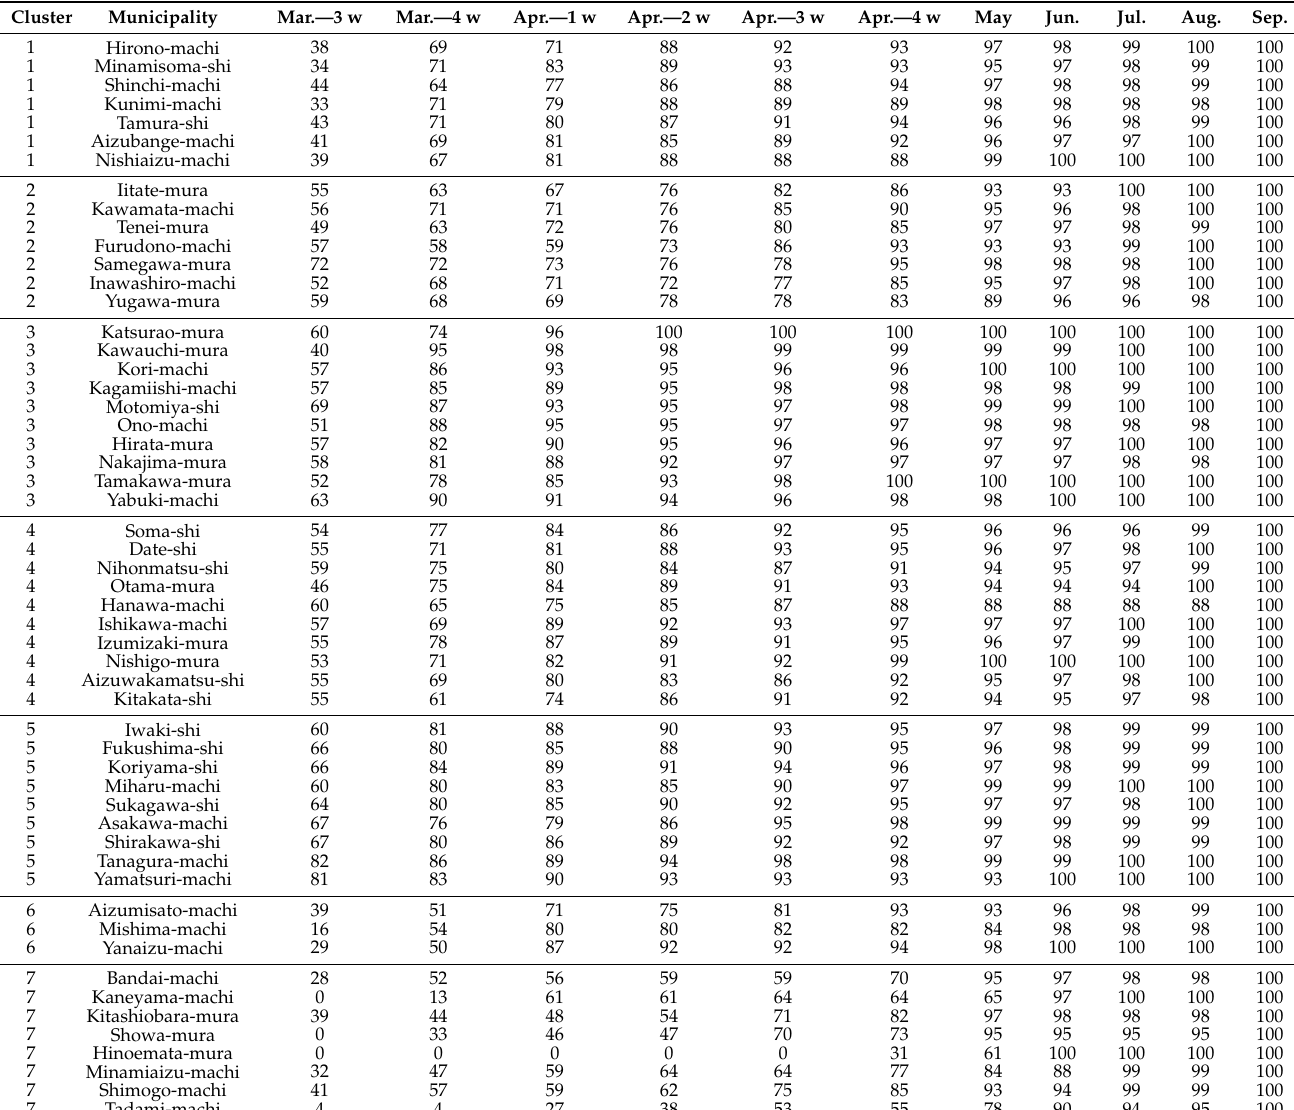
Table 1. Seven clusters of municipalities with similar road